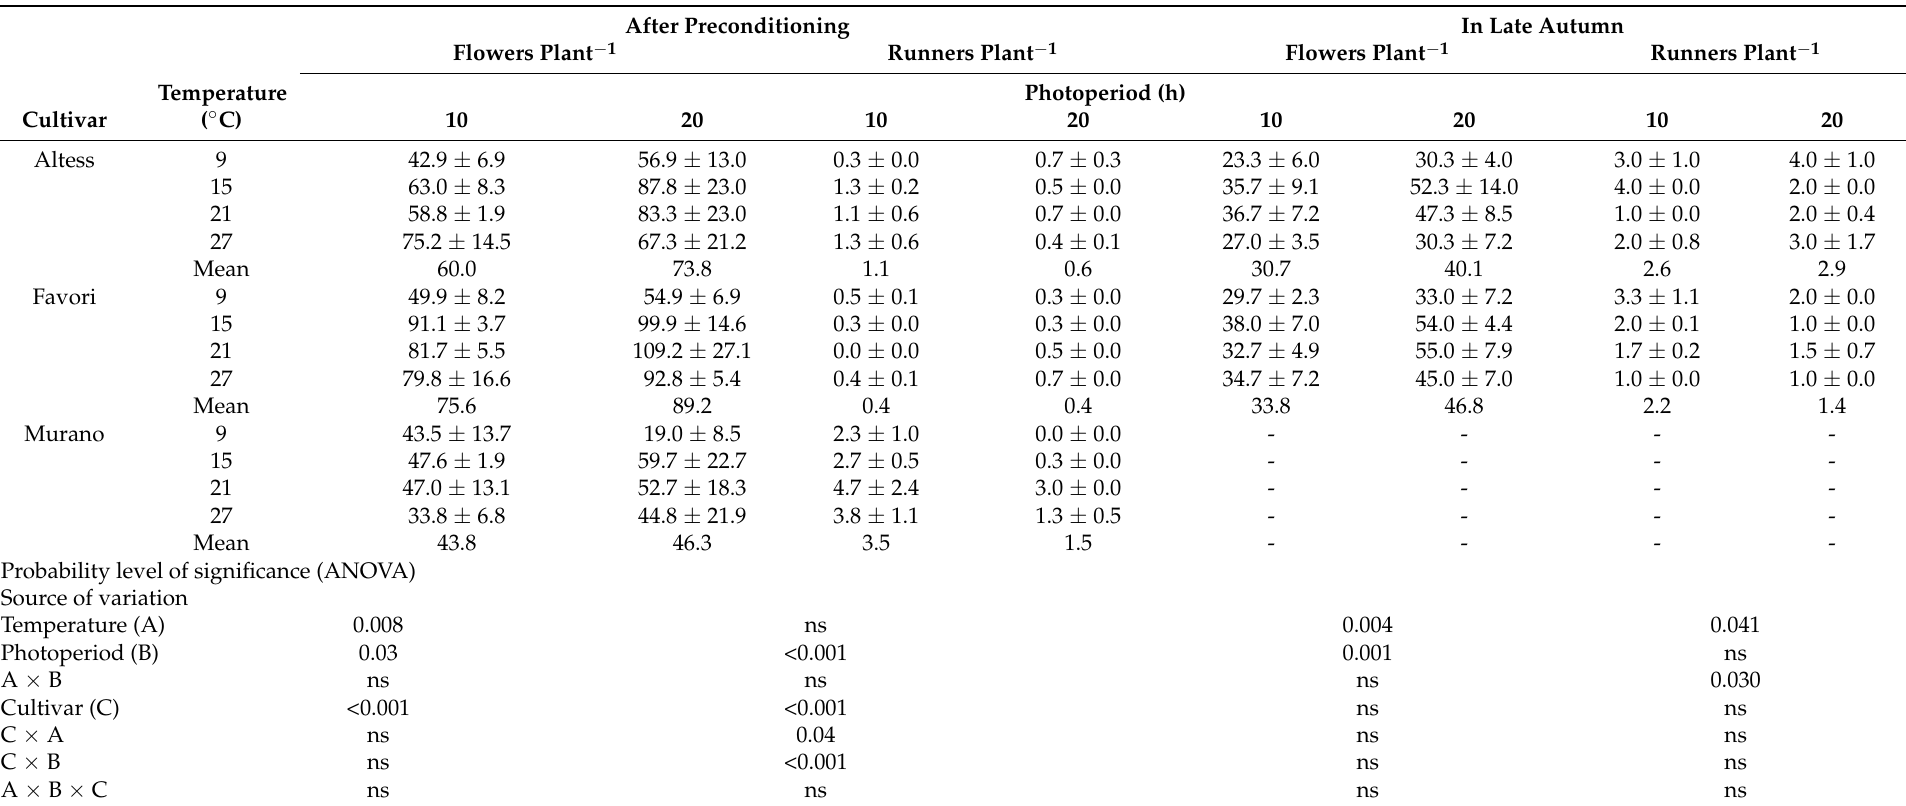
Table 2. Effects of temperature and photoperiod during plant raising on growth and flowering of three EB strawberry cultivars as assessed by 10 weeks of forcing started immediately after 4 weeks of preconditioning, and by 8 weeks of forcing started in late autumn after completion of plant raising (preconditioning + outdoor treatment). In both cases the plants were forced in a heated greenhouse maintained at 20 h light and 20 ◦ C. The data are means ± SD of three replicates, each with 3 or 1 plant respectively, of each